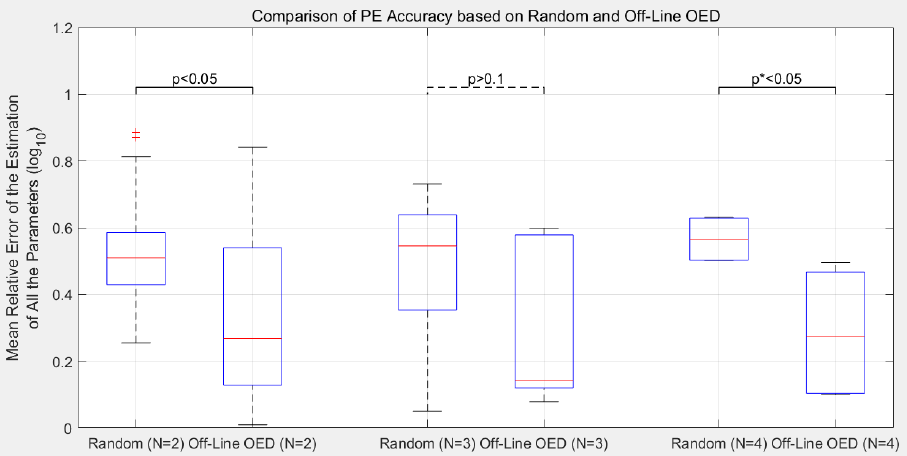
Figure 9. Comparison of the PE accuracy based on random and off-line OED experiments. p values stand for one-way t-test results (normal distributions), p * value is for one-sided Mann-Whitney U-tests. The random and off-line cases for N = 3 do not pass Kolmogorov-Smirnov normality test.